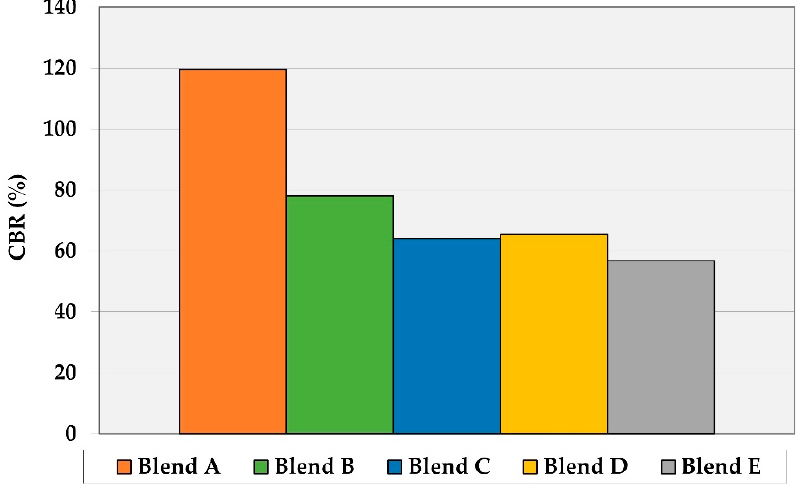
Figure 5. CBR values for each